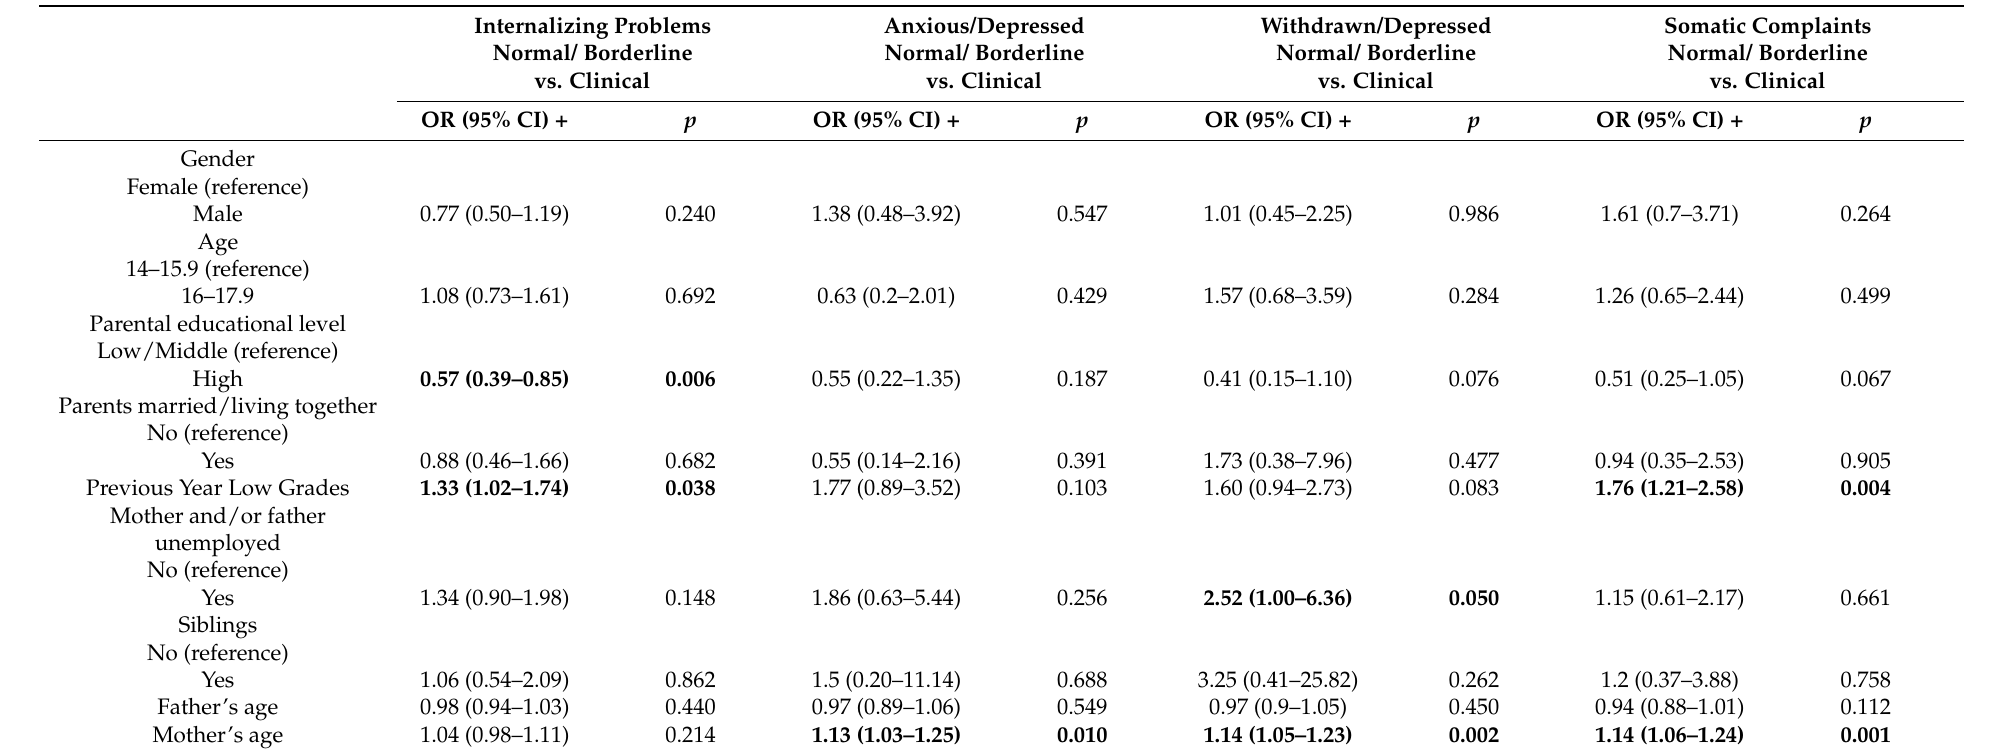
Table 4. Results from multiple logistic regression analysis with clinical internalizing problems (in all subscales and in total) as the dependent variable for Greece. Bold cells denote statistically significant